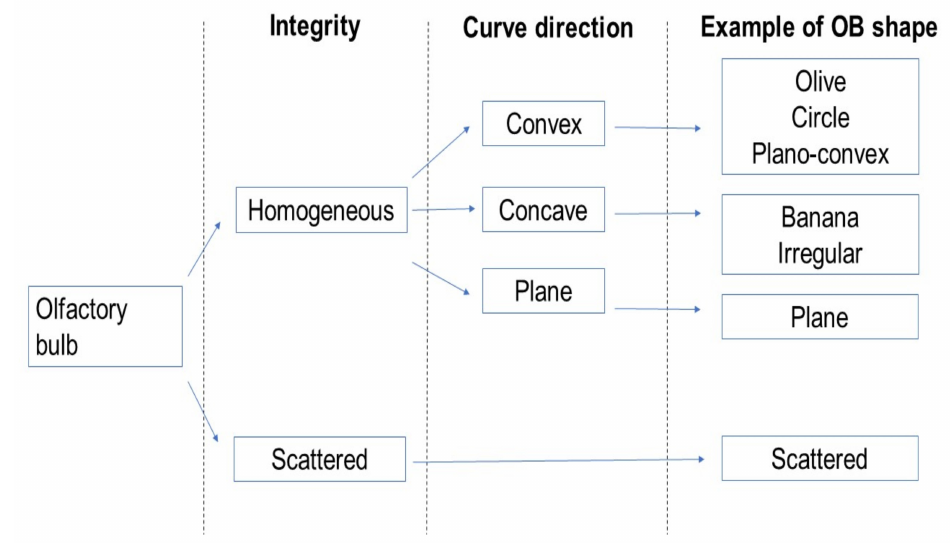
Figure 1. Classification of OB shapes.